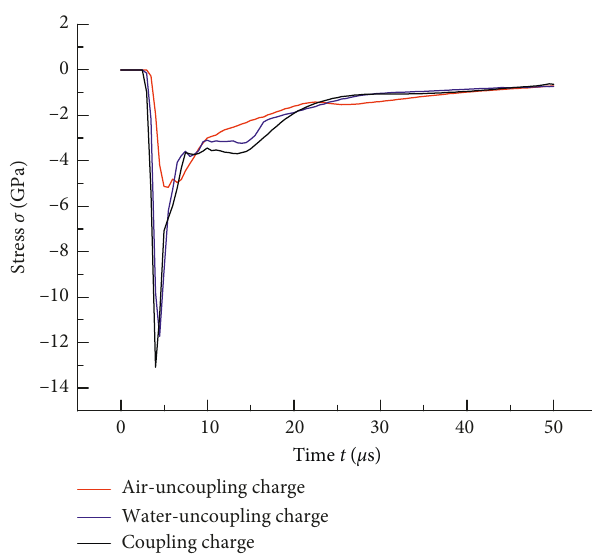
Figure 17: Comparison of the pressure of blasting hole wall with different charging methods.